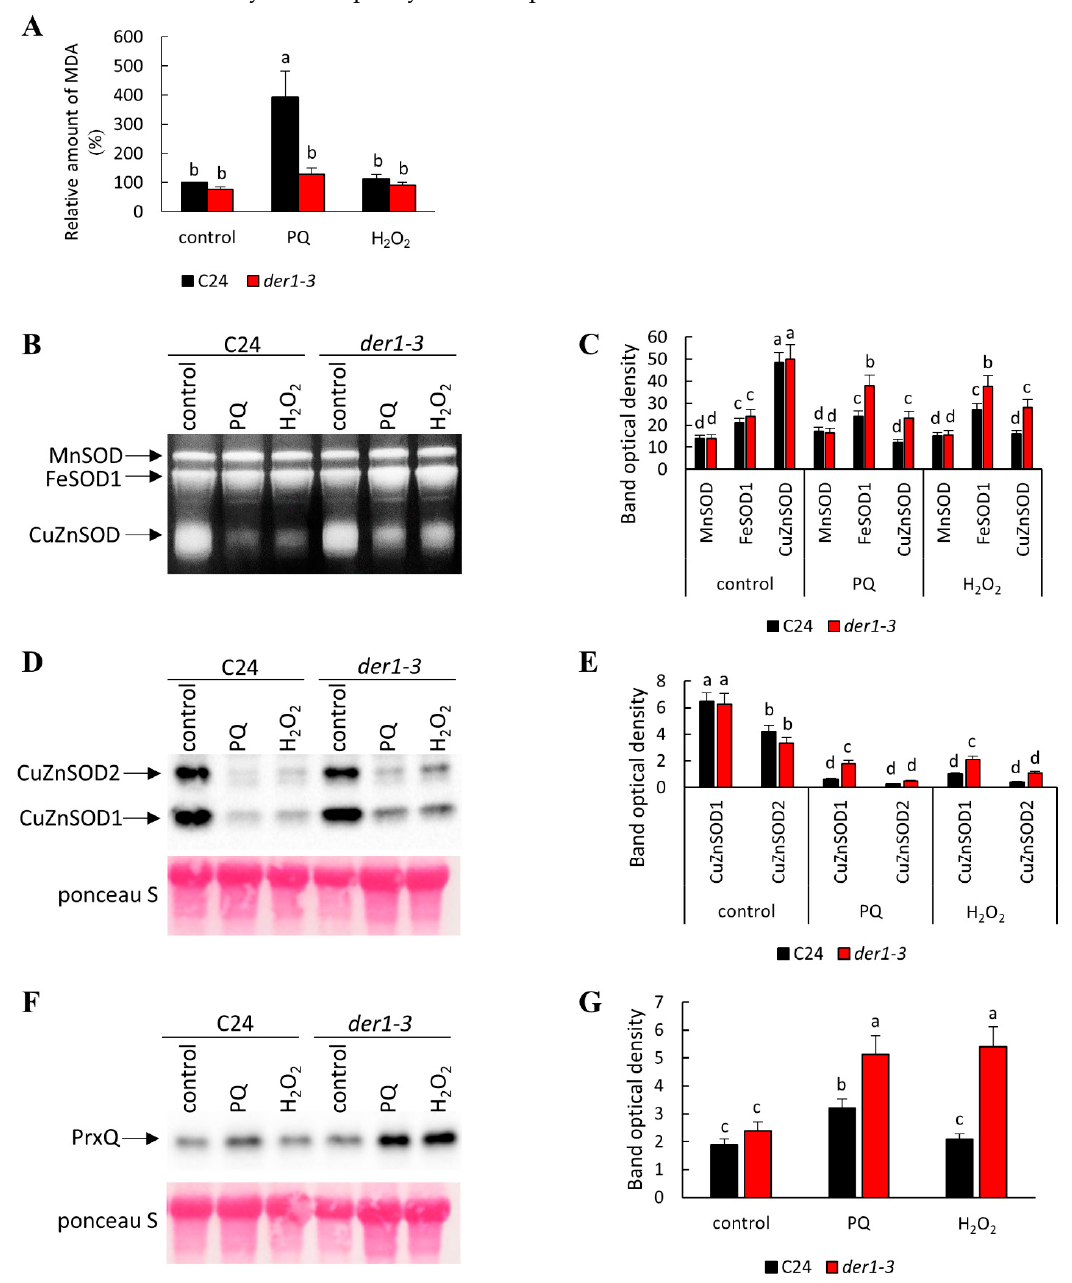
Figure 7. Estimation of lipid peroxidation and antioxidant capacity in plants of C24 wild-type and der1–3 mutant. 3-day-old plants germinated on the control media were transferred to 0.1 µmol·L − 1 of PQ- and 3 mmol·L − 1 of H 2 O 2 -containing media and biochemical analysis was performed 11 days after the transfer (plants were 14 days old). ( A ) Relative quantification of malondialdehyde content. ( B , C ) Visualization of superoxide dismutase (SOD) isoforms activity ( B ) and quantification of individual band densities ( C ) on native polyacrylamide gels. ( D , E) Immunoblot of CuZnSOD1 and CuZnSOD2 isoforms ( D ) and quantification of band densities ( E) . ( F , G ) Immunoblot of peroxiredoxin Q abundance ( F ) and quantifi- cation of band densities ( G ). Different lowercase letters above the bars ( A , C , E , G ) represent statistical significance between treatments according to t-Test at p value <0.05. Uncropped, full original images of immunoblots are provided in Figures S9 and S10.